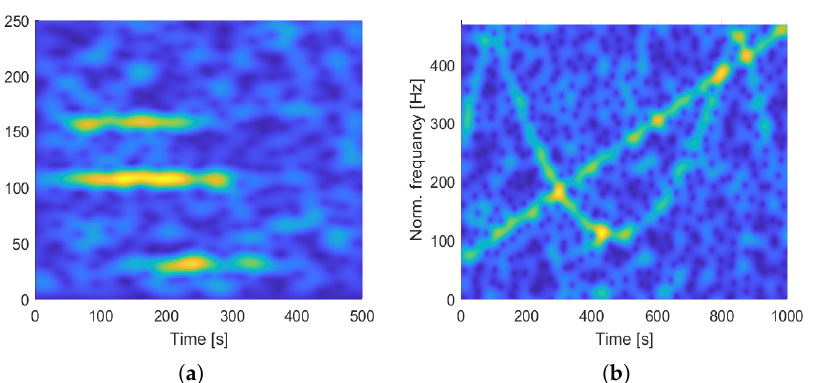
Figure 10. Entropy maps obtained by applying the 2DLEM method with the proposed entropy based on the generalized Dombi operator for SNR = 0 dB. ( a ) Entropy map for the first signal. ( b ) Entropy map for the second signal.